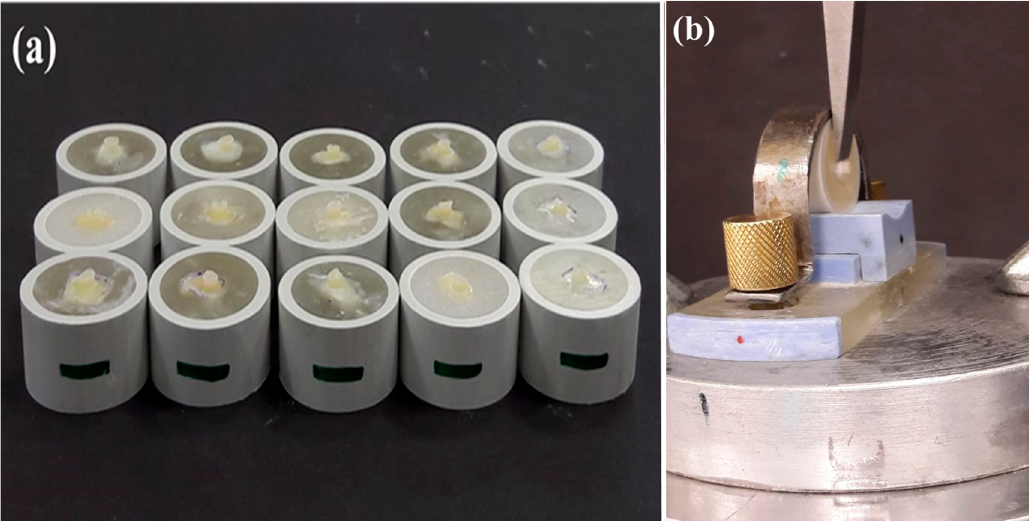
Figure 2. ( a ) Prepared samples bonded to dentin. ( b ) Sample mounted for shear bond